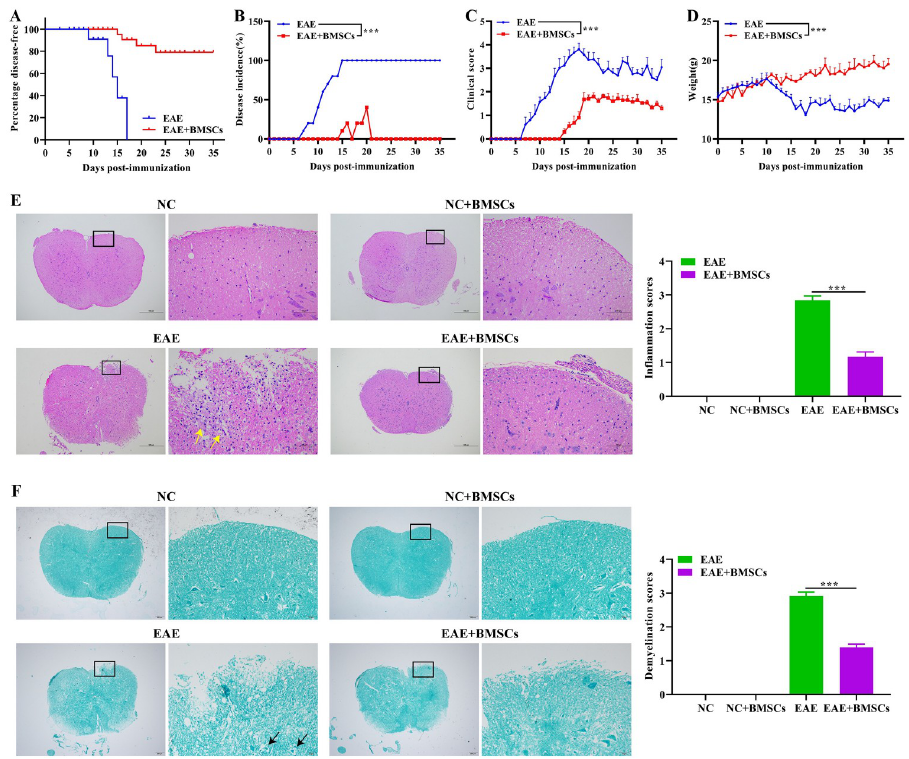
Fig 4. Effect of BMSCs transplantation on clinical signs and histological changes during EAE progression in mice. The body weight and clinical scores of all of mice were assessed daily according to the same criteria for 35 continuous days. (A) Percentage disease-free, (B) disease incidence, (C) clinical scores and (D) body weight, were monitored. On the 16th day post-immunization, (E) H&E staining was used to observe inflammatory infiltration in the lumbar spinal cord of mice, and result of inflammation score. Scale bar = 500 or 100 μ m. The yellow arrow indicated inflammatory cell infiltration. (F) LFB staining showed demyelination in the lumbar spinal cord of mice, and result of demyelination score. Scale bar = 500 or 100 μ m. The black arrow indicated demyelination. In all cases, Values are mean ± SD (n = 15 for each group; ��� P < 0.001).